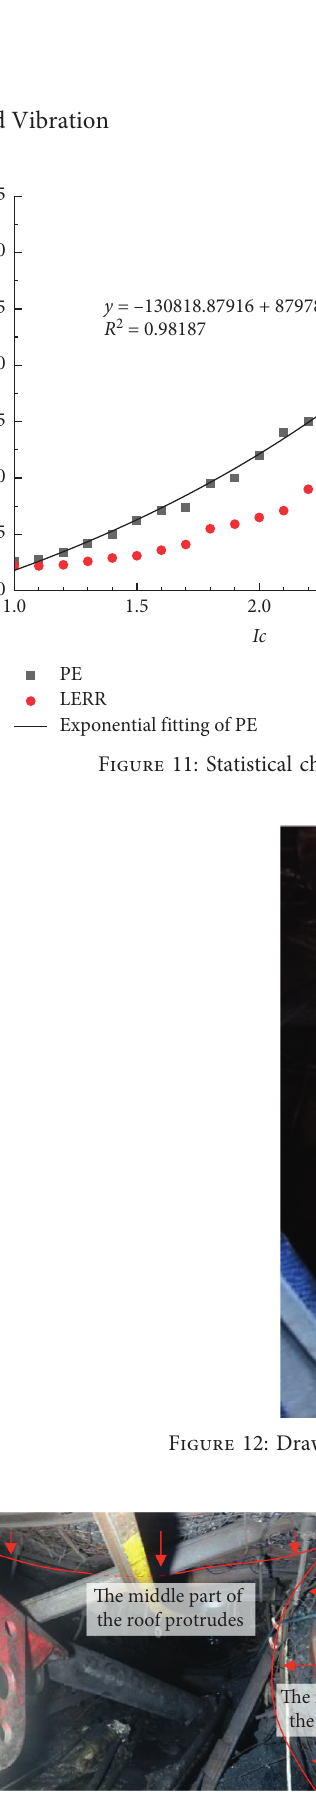
Figure 13: Upper drift impact damage